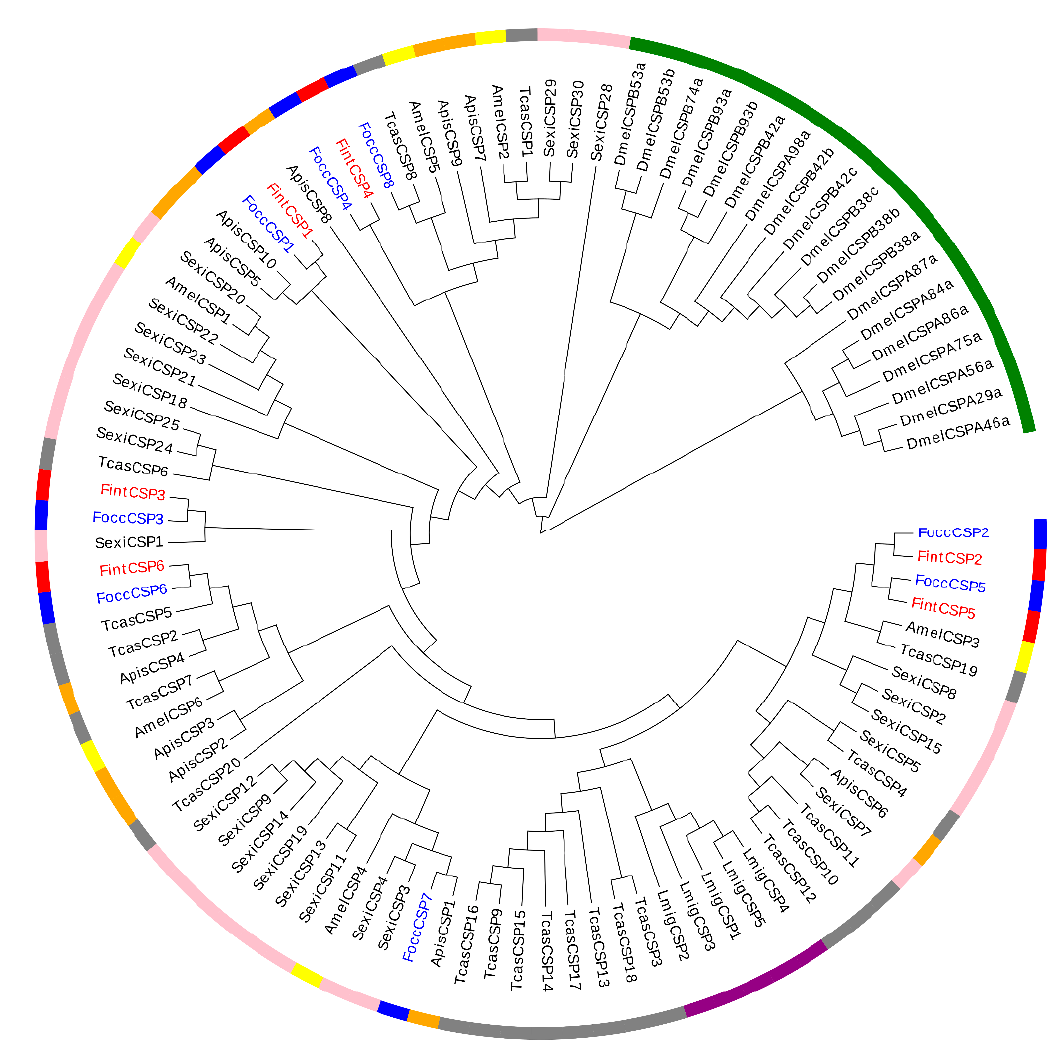
Figure 5. Maximum likelihood tree of CSPs from two Frankliniella species and representative species from six other insect orders. Species abbreviations are: Focc, in blue, Frankliniella occidentalis (Thysanoptera); Fint, in red, Frankliniella intonsa (Thysanoptera); Apis, in orange, Acyrthosiphon pisum (Hemiptera); Amel, in yellow, Apis mellifera (Hymenoptera); Dmel, in green, Drosophila melanogaster (Diptera); Lmig, in purple, Locusta migratoria (Orthoptera); Sexi, in pink, Spodoptera exigua (Lepidoptera); Tcas, in grey, Tribolium castaneum (Coleoptera).